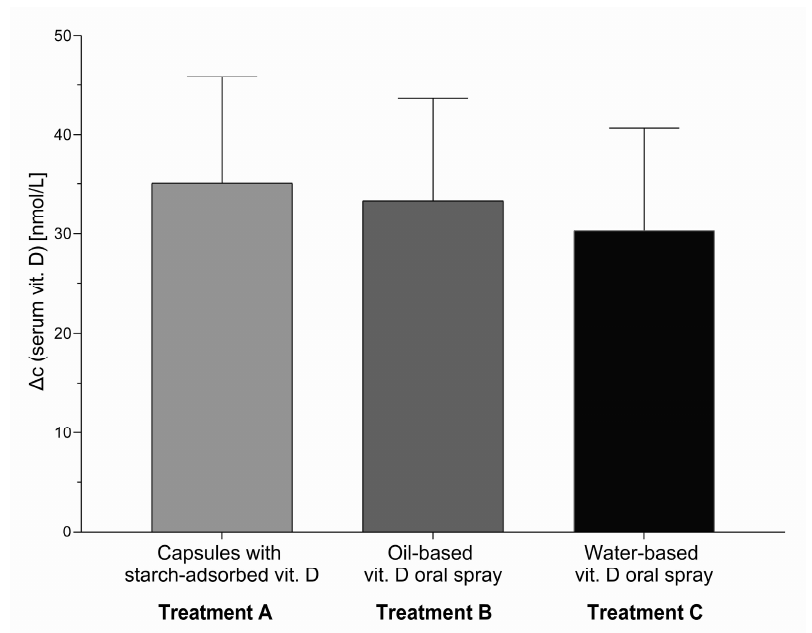
Figure 3. Treatment effect (change in serum 25-OH-vitD concentration in comparison with the control group D) of the intervention (8 weeks of daily supplementation with 1000 IU; 25 µg vitamin D) for three tested vitamin D formulations in comparison to control group, with 95% CI: The effect was statistically significant ( p < 0.0001) in all three intervention groups.